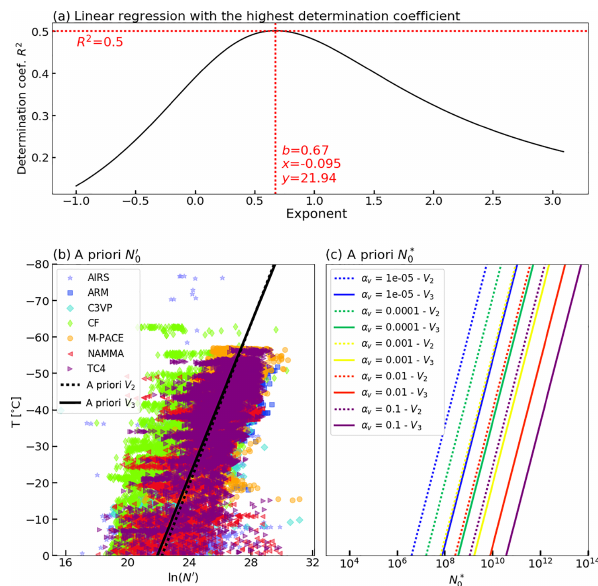
Figure 3. Determination of the a priori value of N ∗ : values of the 0 coefficient of determination R 2 for different values of b and values of the coefficients for the best fit (a) , result of the linear regression ) for the entire dataset as a function of temperature (with on ln (N (cid:48) 0 b = 0 . 67) (b) and corresponding N ∗ for different values of extinc- 0 tion (c)